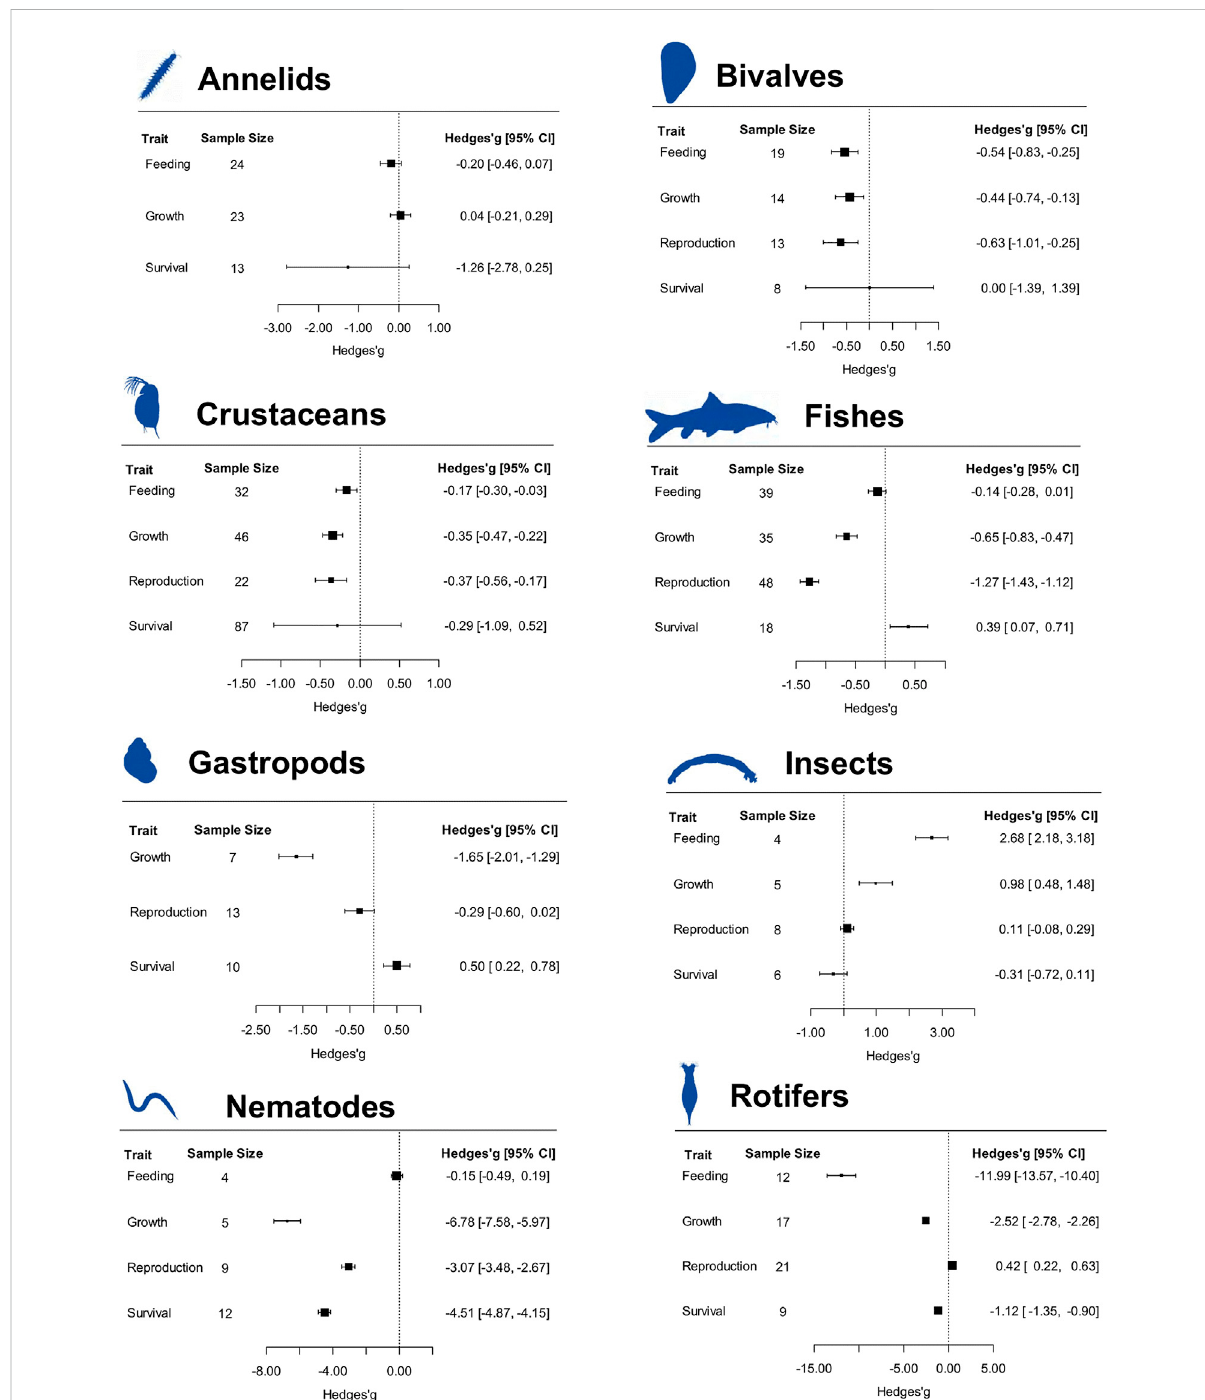
FIGURE 1 Forest plot ofeffect sizes ofresponse categoriesbased on taxonomic groupings.Analyses wereconducted usinga mixed-effects model. Black boxes denote the hedges ’ g valueand horizontal lines denote the 95% con fi dence intervals (CI) for each hedges ’ g value. Hedges ’ g values of less than 0.2representsmalleffects,valuesbetween0.2and0.5representmoderateeffects,withvaluesgreaterthan0.5suggestinglargeeffects.Therelative size of the black boxes shows the relative effect size of the studies included in each